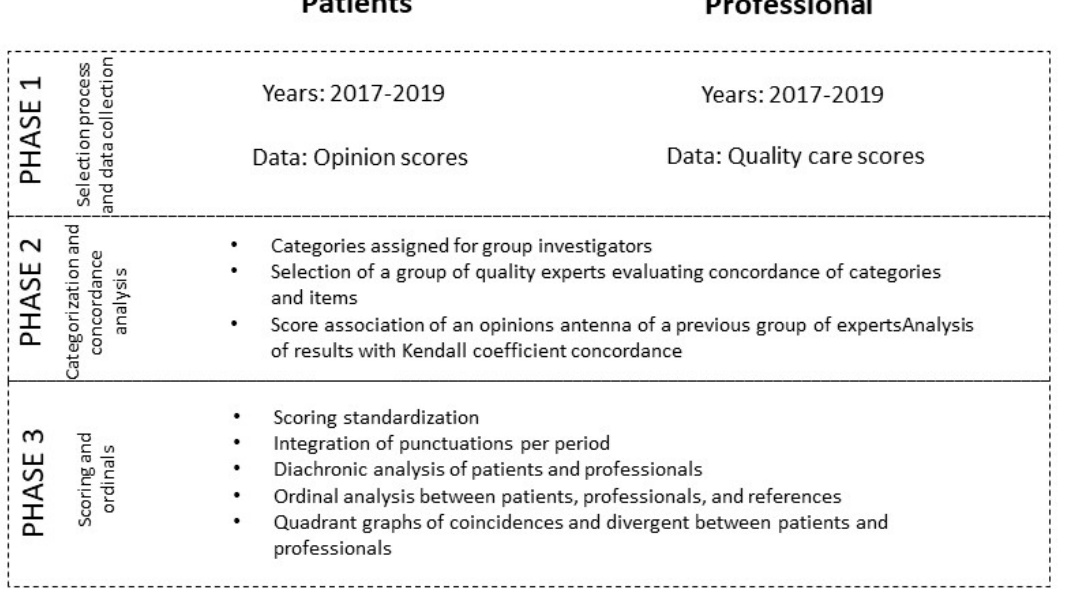
Figure 1. A three-phase methodological approach to studying patient opinions and professional culture.